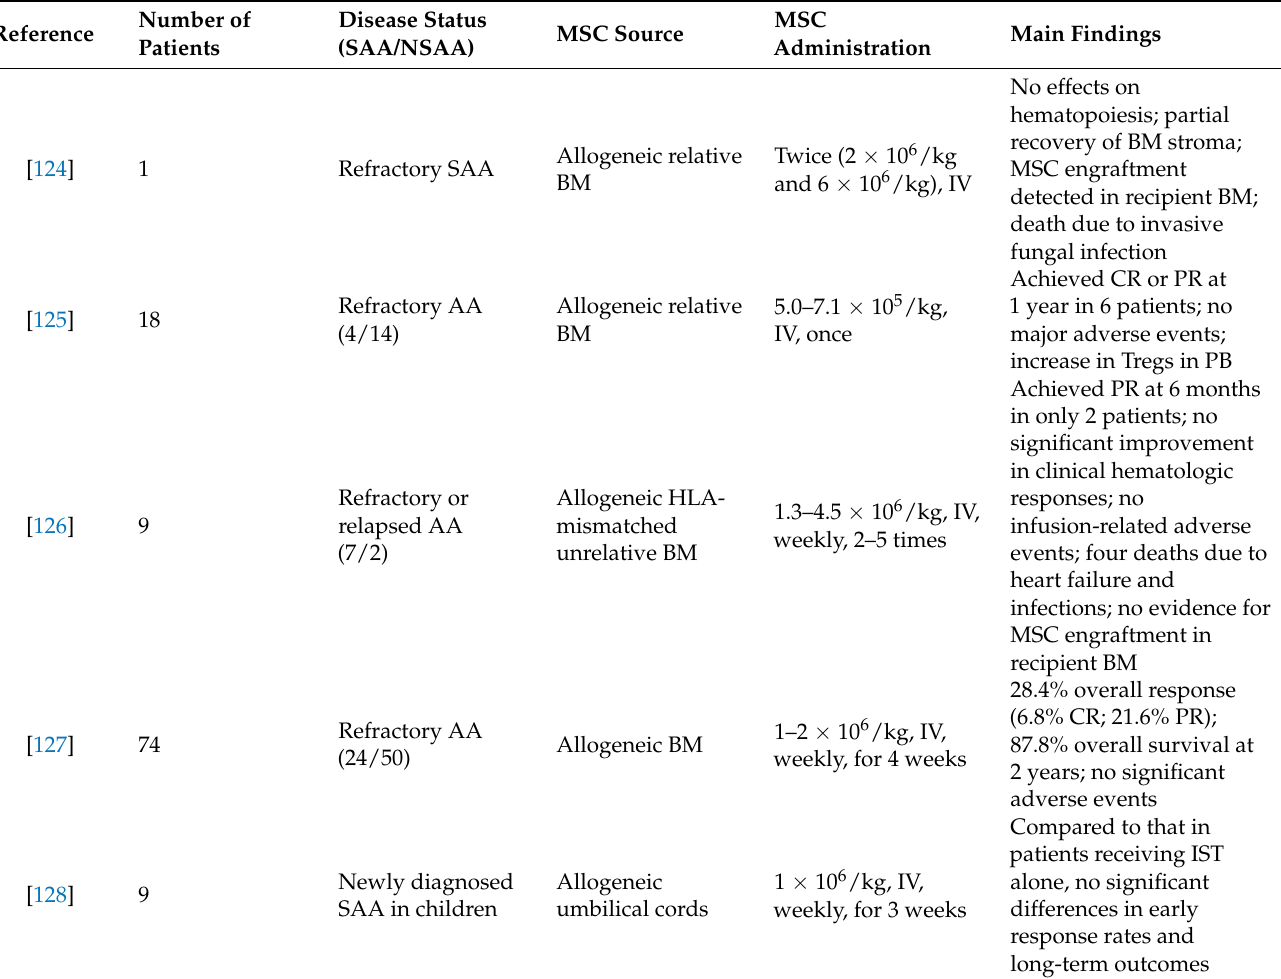
Table 2. Studies on MSC infusion for patients with